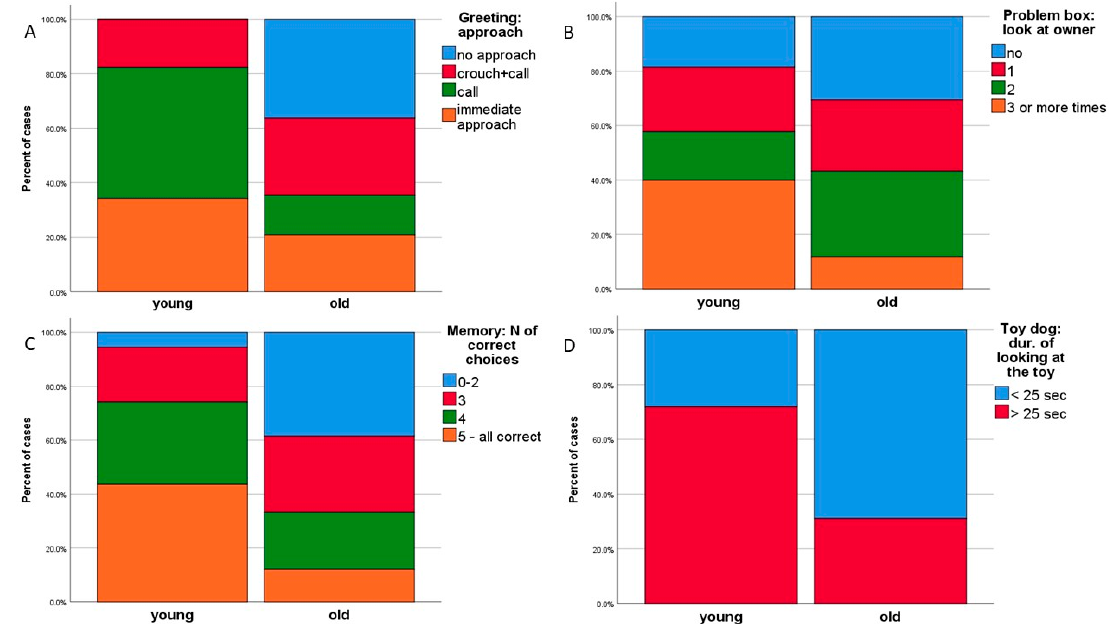
Figure 2. Proportions of subjects with age categories in four subtests.